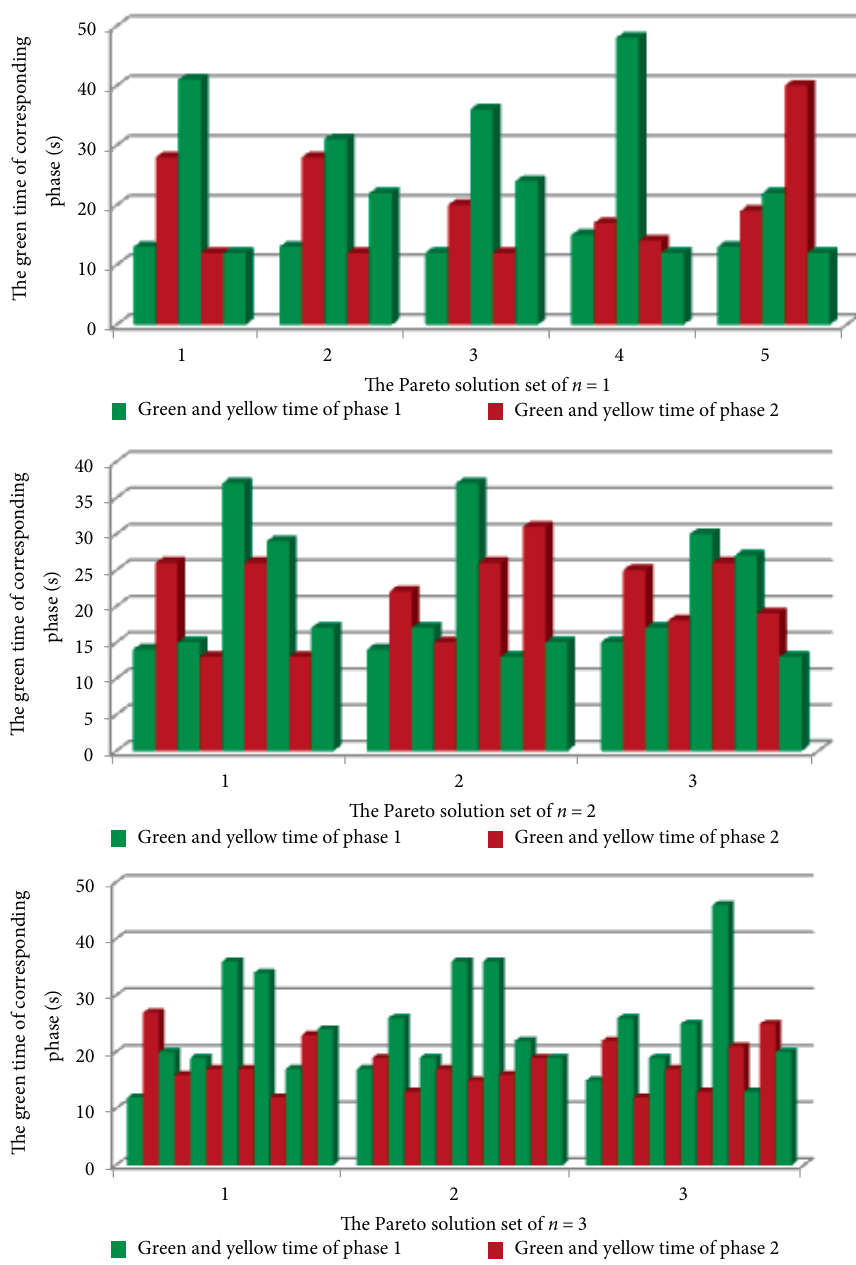
Figure 8: Pareto solution set corresponding to different n for 9